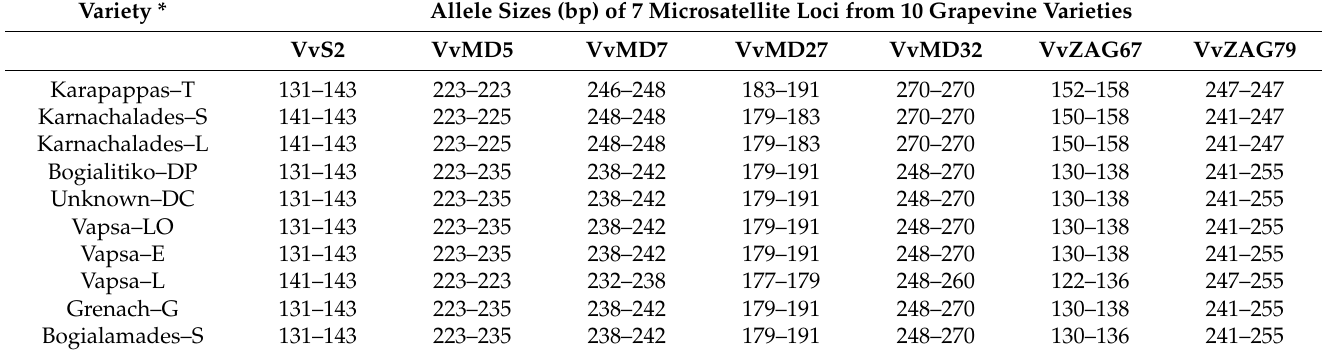
Table 1. Allele sizes (bp) of 7 microsatellite loci from 10 grapevine